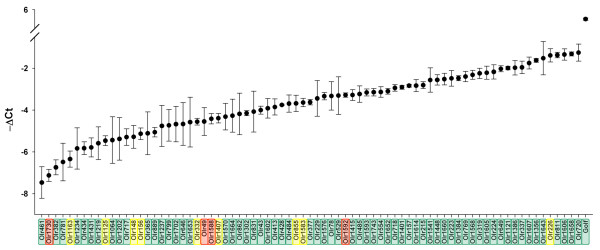
Delta Ct values for 77 OR genes. Results of RTqPCR (means of technical triplicate for each gene), are expressed as delta Ct values (Cycle threshold), using Hprt mRNA as a reference (Ct OR-Ct Hprt). The analyses were performed on three samples and the size of the vertical bars corresponds to the standard deviation. The curve links the mean Ct values obtained with these three samples. The name of the OR genes are indicated on the x axis: in green are genes identified as expressed, in yellow the OR genes identified as weakly expressed and in red are the OR genes identified as not expressed by microarray hybridization. As indicated by the size of the vertical bars defining the cycle threshold (Ct) values for any given analyzed RNA, the amount of mRNA differs by 0.08 to 2.2 Ct between the three samples.